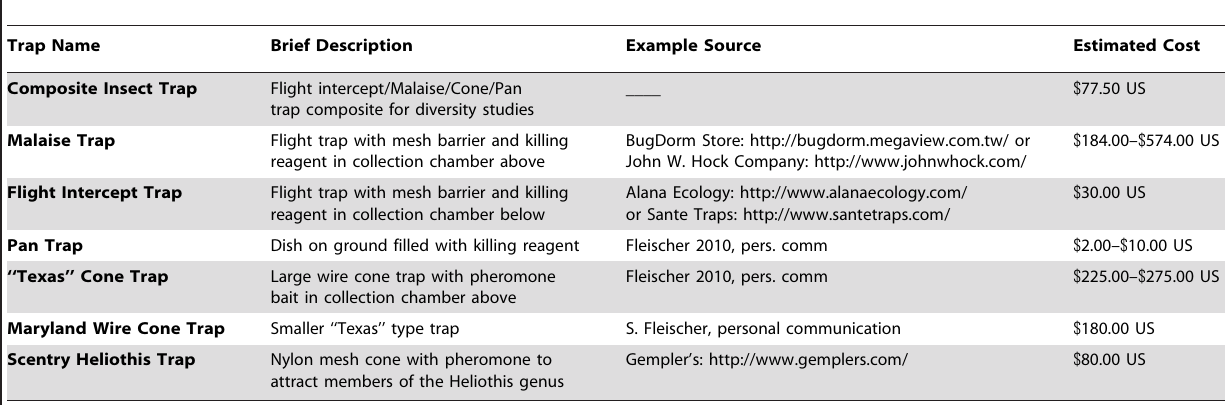
Table 2. Prices for the Composite Insect Trap and other commonly used trap types collected from major biological